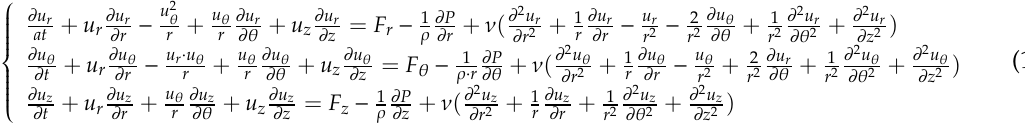
Figure 3. Pressing motion of the clutch